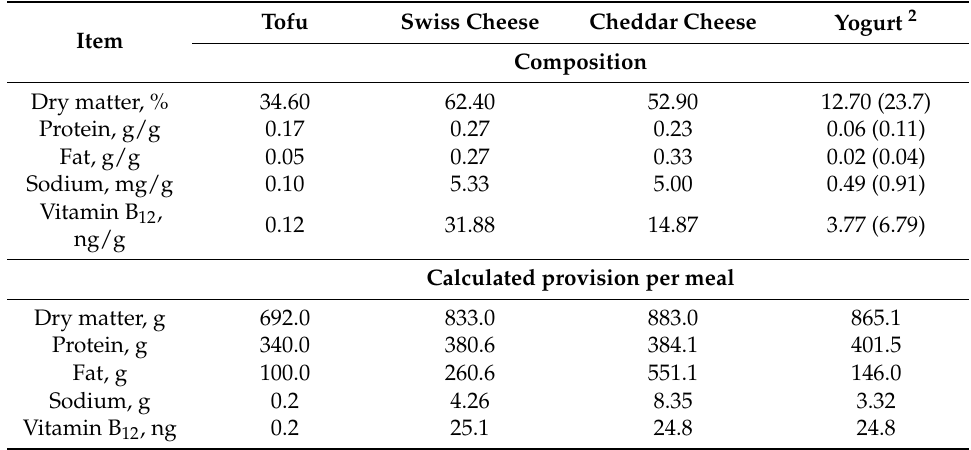
Table 1. Composition of the experimental products (as-fed basis) and their calculated provision of dry matter, protein, fat, salt, and vitamin B 12 1